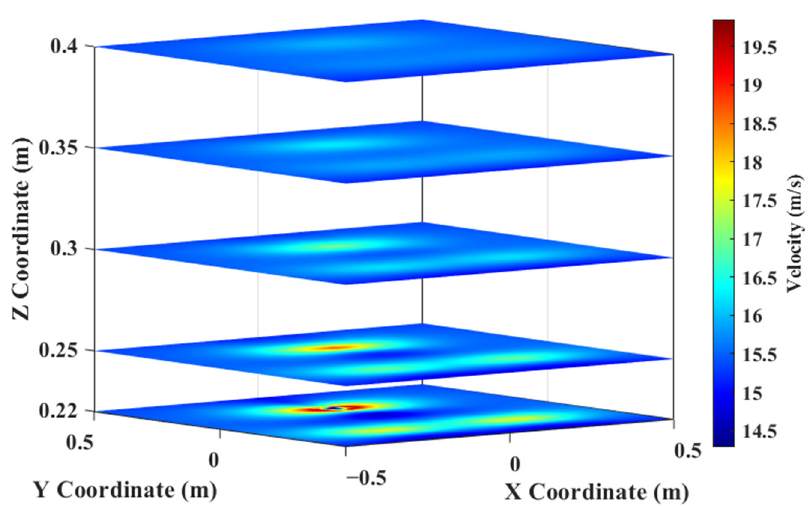
Figure 12. Velocity nephograms of CFD with boundary condition of 90°, 15 m/s.